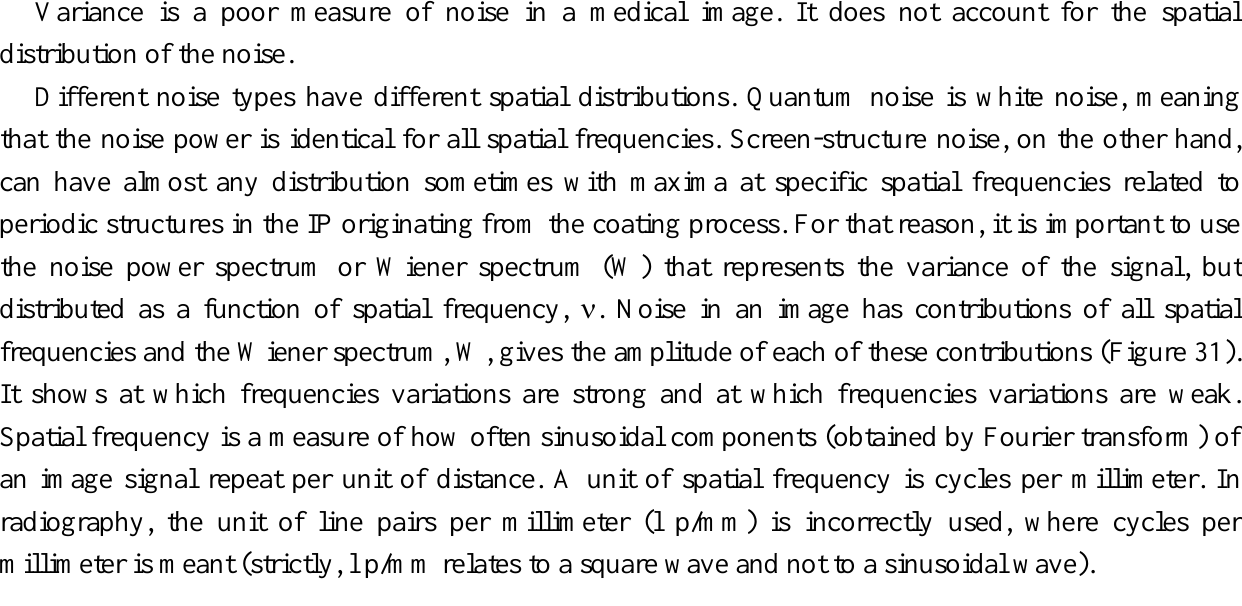
Figure 31. Schematic representation of Wiener spectrum